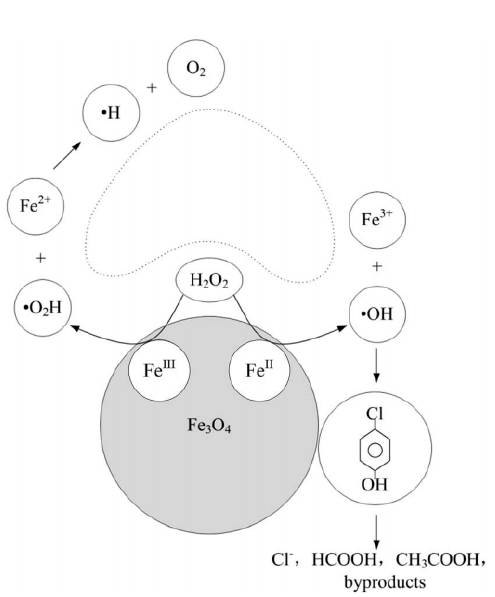
Figure 18. Illustration of the mechanism of catalytic oxidation of 4-chlorophenol by Fe 3 O 4 nanopar- ticles. (Reprinted with permission from [75]. Copyright © 2019 WILEY-VCH Verlag GmbH & Co. KGaA, Weinheim, Germany).